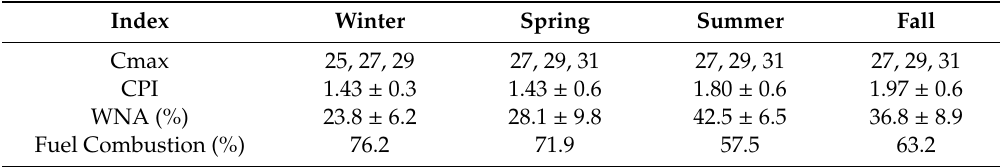
Table 7. Seasonal n-Alkane index.